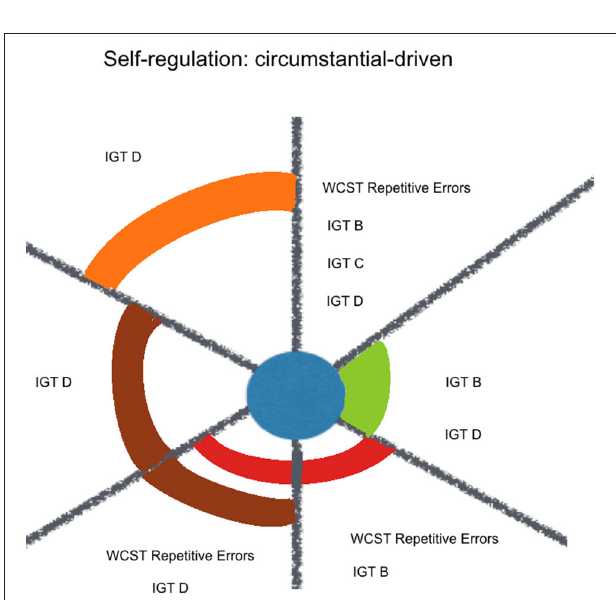
FIGURE 4 | Kindness estimation of neuropsychological performance, considering relative and joint influence of psychosocial and sociodemographic factors: circumstantial-driven self-regulation. Legend: Significant (non-)linear models with all of their factors weighted above Pc 75 (among all the models including each of them). Kindness in blue, Social Desirability in green, Mother’s Educational Level in red, Sex in purple, Course in brown, Term in